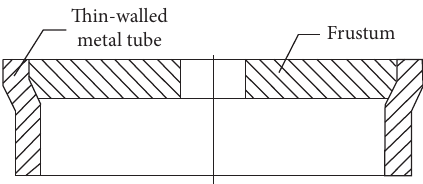
Figure 9: Structure of the buffer No. 2.